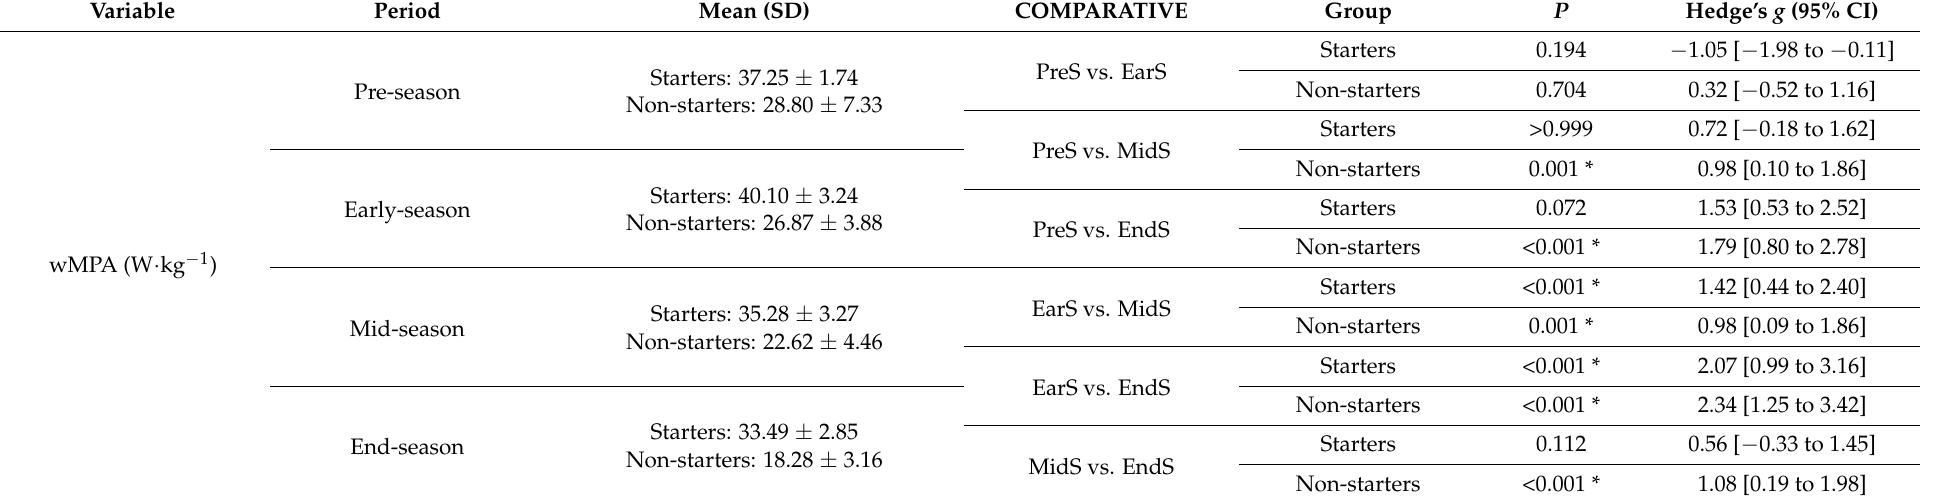
Table 2. Within-group differences for pairwise comparisons between season periods in wMPA for starter and non-starter players.